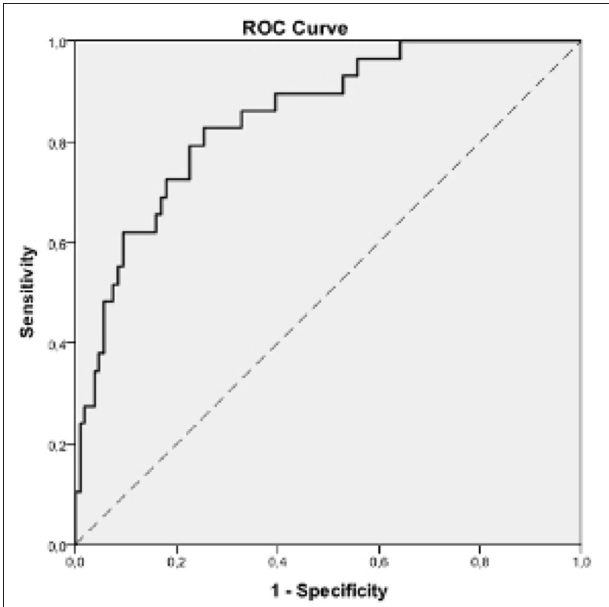
FIGURE 2 | ROC analysis to predict sarcopenia outcome (Area under the curve = 0.849, p -value < 0.001, CI (95%) = [0.774; 0.924]). CI, Confidence Interval; ROC, receiving operating characteristic curve. Cut off value of ROC curve: